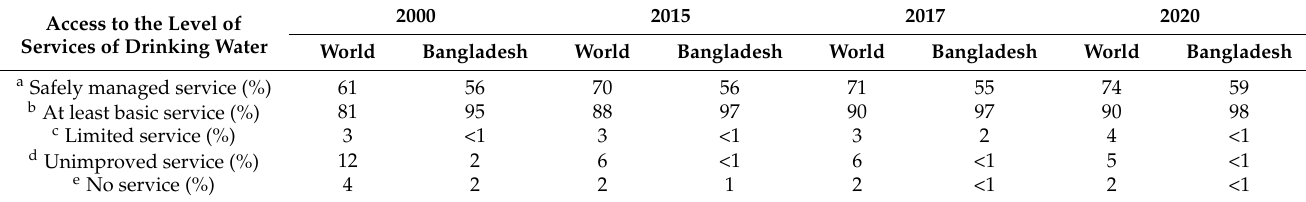
Table 2. Comparison of drinking water service level between Bangladesh and the rest of the world